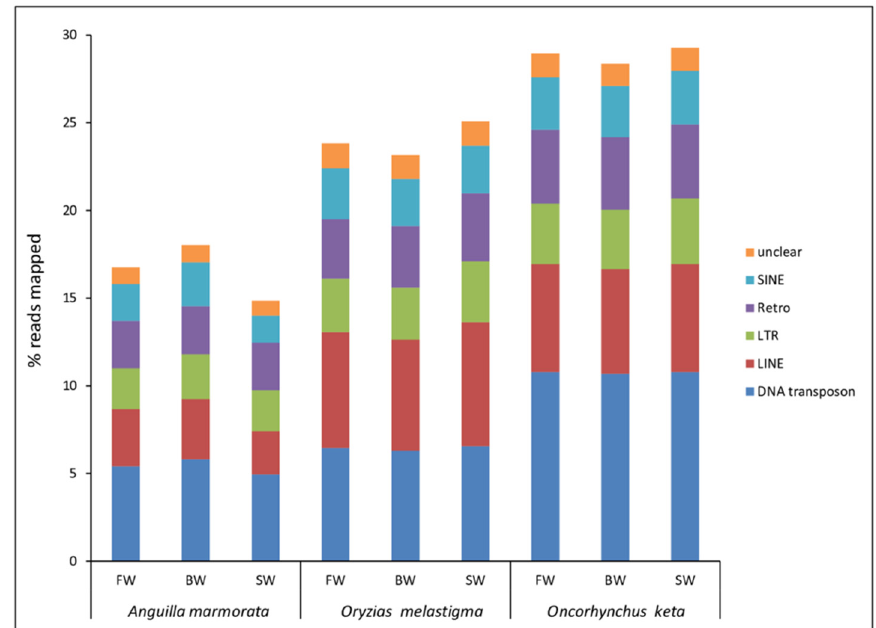
Figure 1. Transcriptional contribution of transposable elements in Anguilla marmorata, Oryzias melastigma, and Oncorhynchus keta gill transcriptomes. FW: freshwater; BW: brackish water; SW: salt water.